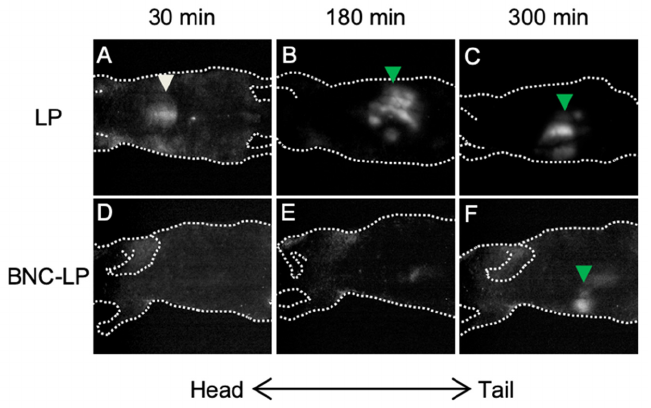
Figure 2. In vivo imaging analysis of LPs and BNC-LP complexes. Each mouse was injected intra- venously with Rh-labeled LPs, either with or without 10 µg of BNCs. After 30, 180, and 300 min, Rh-derived fluorescence was detected from the ventral side of mice using an in vivo imaging system OV-100. The orientation (head and tail) of mice is shown by arrows. White and green arrow- heads indicate liver and intestine, respectively. Table 1. Sizes and surface charges of BNCs, LPs, and BNC-LP complexes.